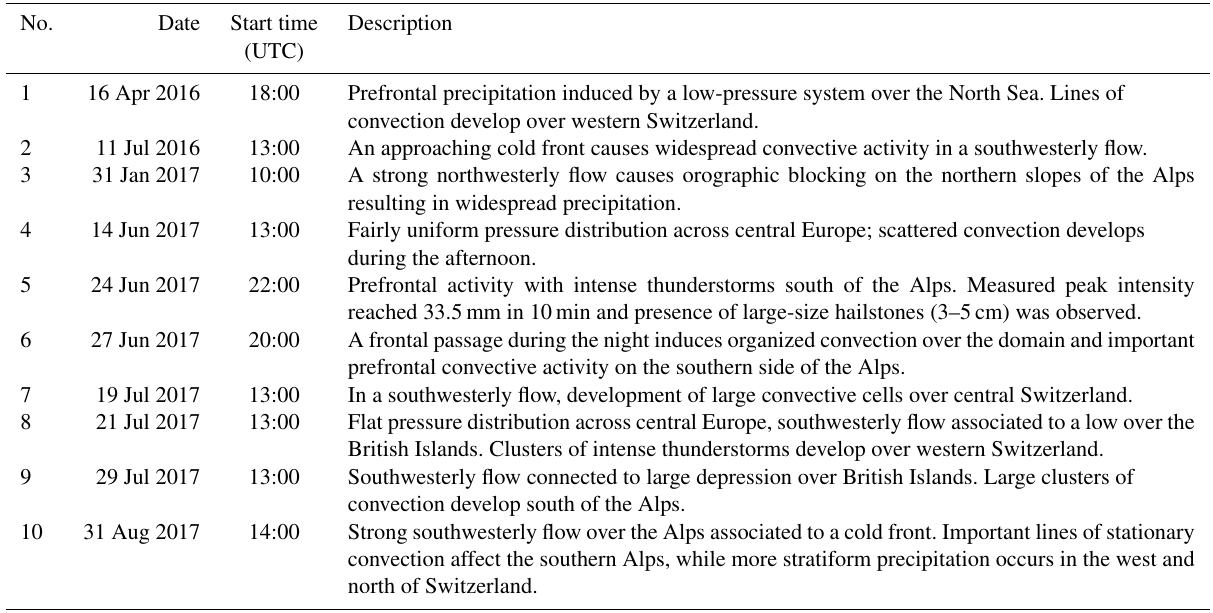
Table 8. Precipitation events in Switzerland (MeteoSwiss). The duration of each event is 12h.